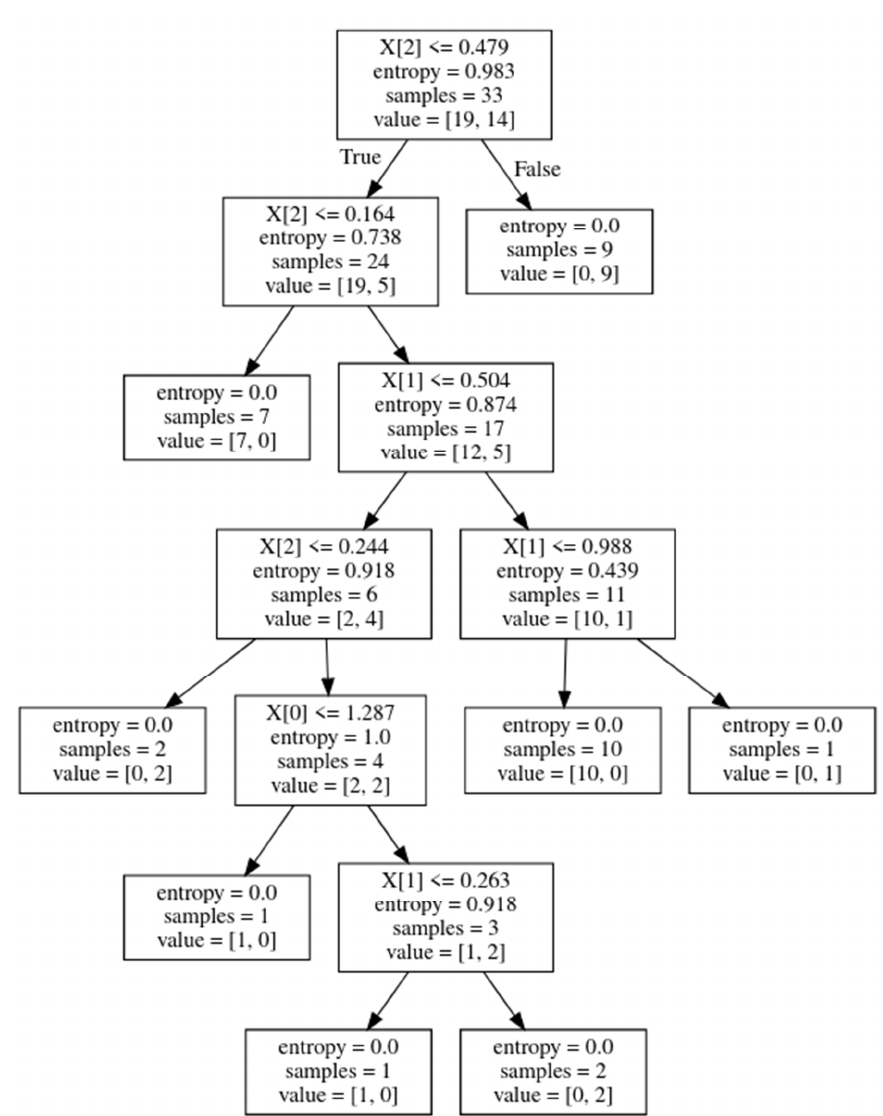
Figure 9. The Decision Tree with entropy values, where X [0] is AP, X [1] is ML, and X [2] is area under the square.